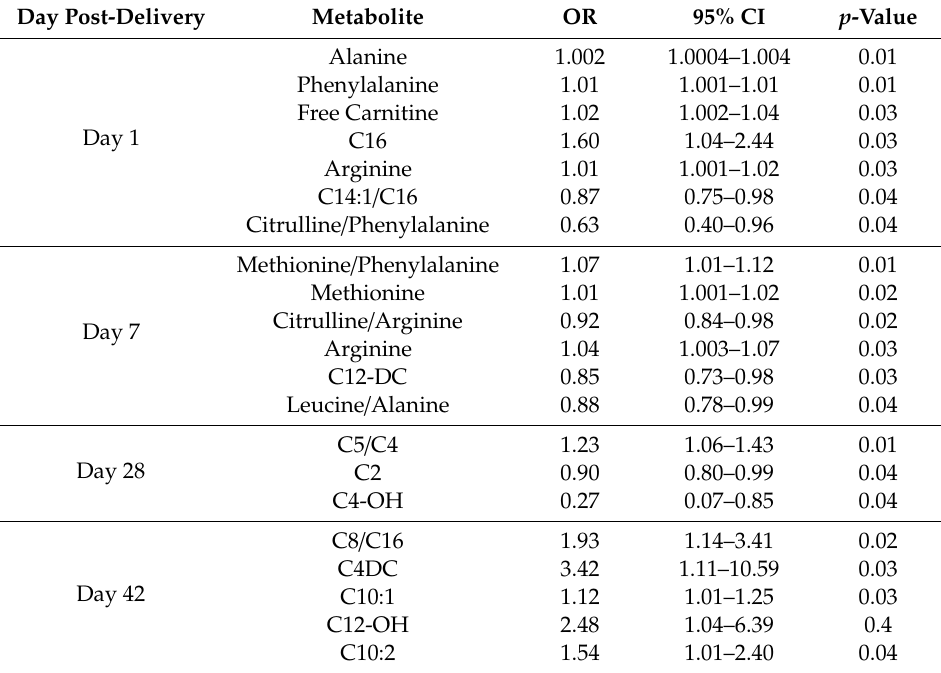
Table 1. Analytes that are associated with an increased risk of necrotizing enterocolitis (NEC) by day. Adjusted for birth weight and gestational age, transfused (Y / N), postnatal steroids (Y / N), late onset sepsis, and retinopathy of